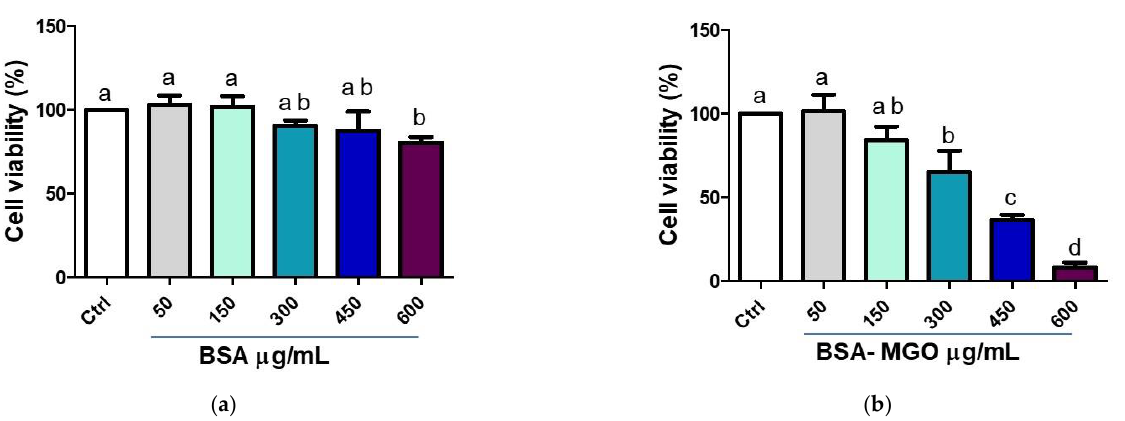
Figure 4. Cell viability after ( a ) BSA or ( b ) BSA – MGO treatment on THP-1 macrophages (M0). MTT assay was performed at 24 h post-treatment. Absorbance was read at 570 nm and cell viability was expressed as % of control (untreated). All data represent the means of at least three replicates ± standard deviation. The analysis of variance was carried out using one-way ANOVA followed by the Tukey’s multiple comparison test: letters denote significant differences among samples (Ctrl vs. 300 µ g/mL BSA p = ns; Ctrl vs. 300 µ g/mL BSA–MGO p <